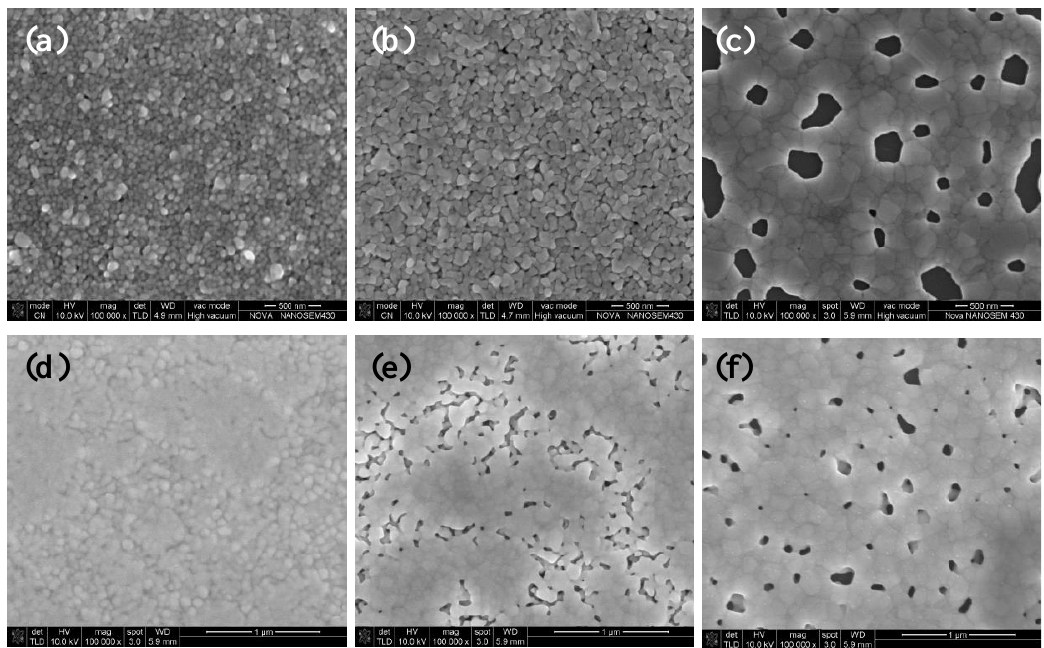
Figure 2. SEM images of heat-cured silver films: Silver films based on the NP ink were cured in ( a ) 100, ( b ) 140, and ( c ) 200 °C for 30 min, respectively; silver films based on the MOD ink were cured in ( d ) 100, ( e ) 140, and ( f ) 200 °C for 10 min, respectively.